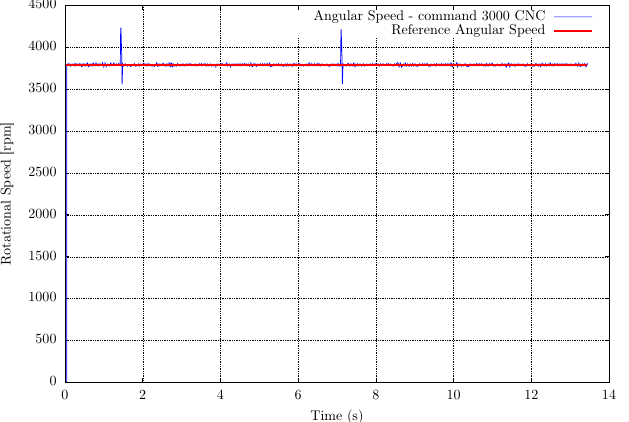
Figure 8. Measurement results for Router CNC spindle measurement at 3000 machining numerical